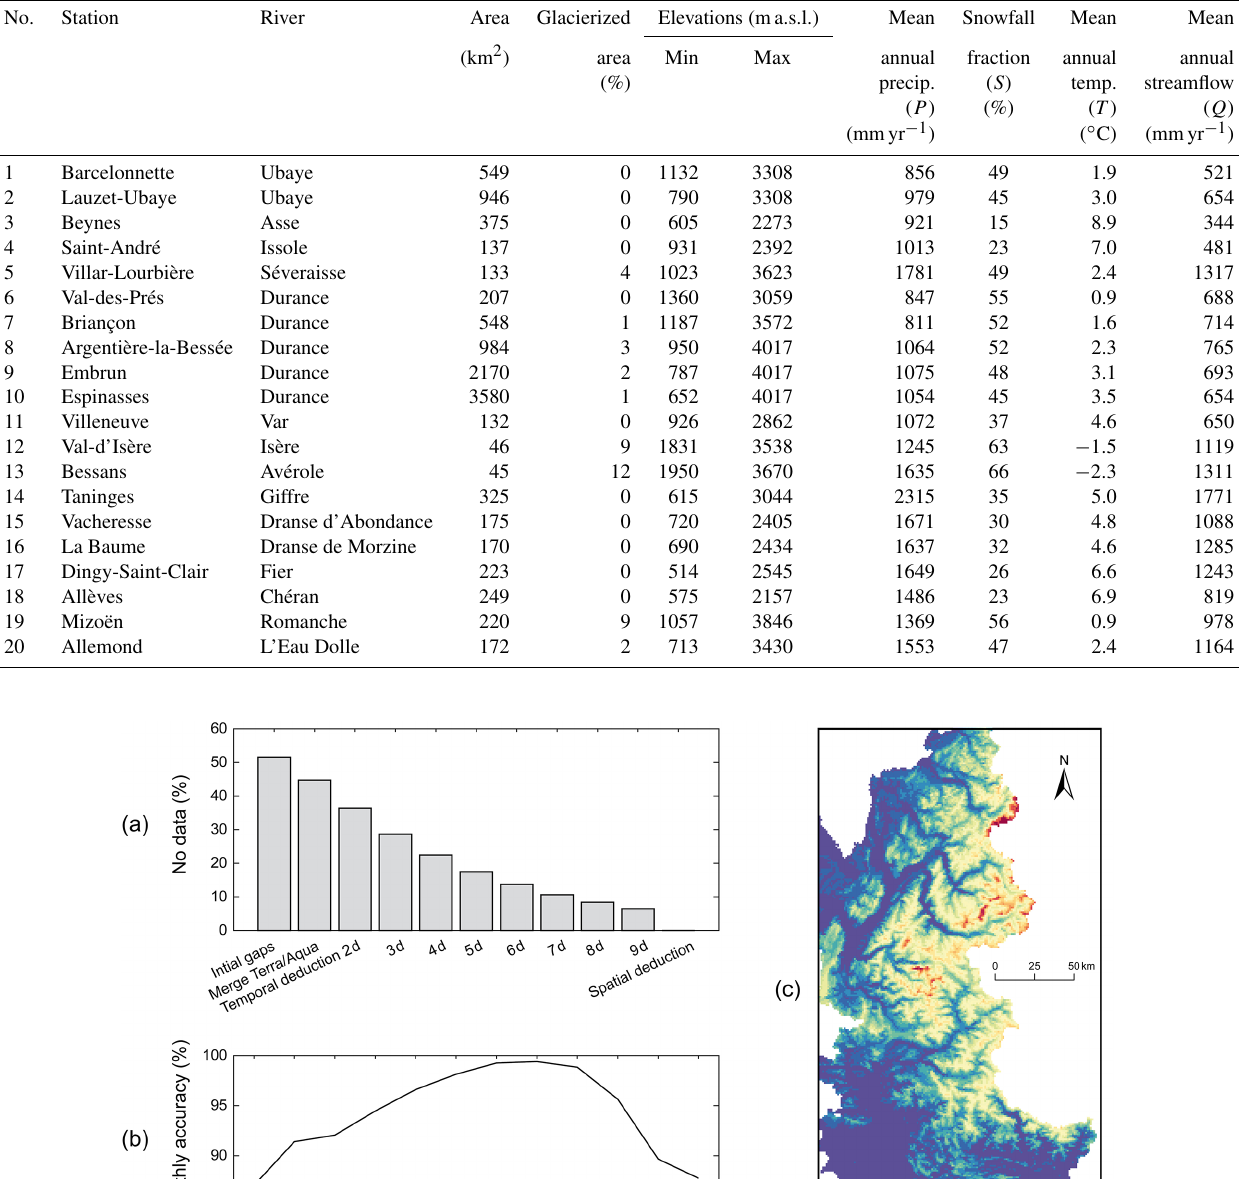
Table 1. Streamflow gauging stations and main catchment characteristics. Percentages of glacierized area were estimated from the World Glacier Inventory (NSIDC, 2012). Mean annual precipitation ( P ), snowfall fraction ( S ), and temperature ( T ) were estimated after calibrating local altitudinal gradients over 2000–2016 using the snow-hydrological inverse approach proposed in the current paper (see Test no. 4 in Table 5).